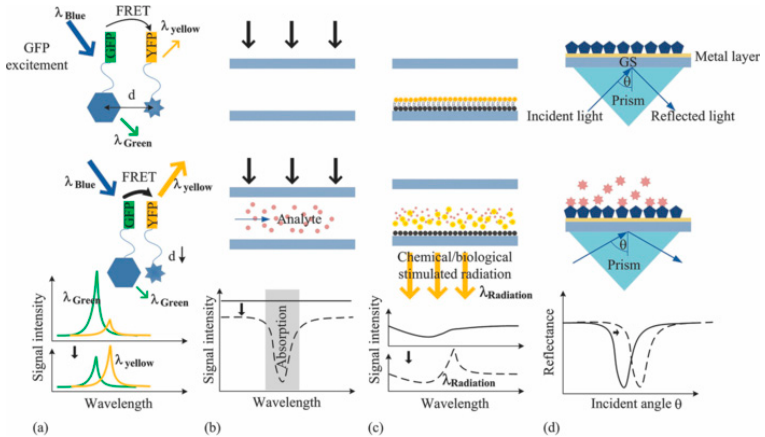
Figure 2. Optical methods. ( a ) Fluorescence (in this case, fluorescent resonance energy trans- fer/FRET), ( b ) absorbance, ( c ) luminescence, and ( d ) surface plasmon resonance (SPR)-based optical detection methods. Reprinted by J. of Biomedical Optics, 16(8), 080901 (2011) © (2011) Society of Photo-Optical Instrumentation Engineers (SPIE) [64].